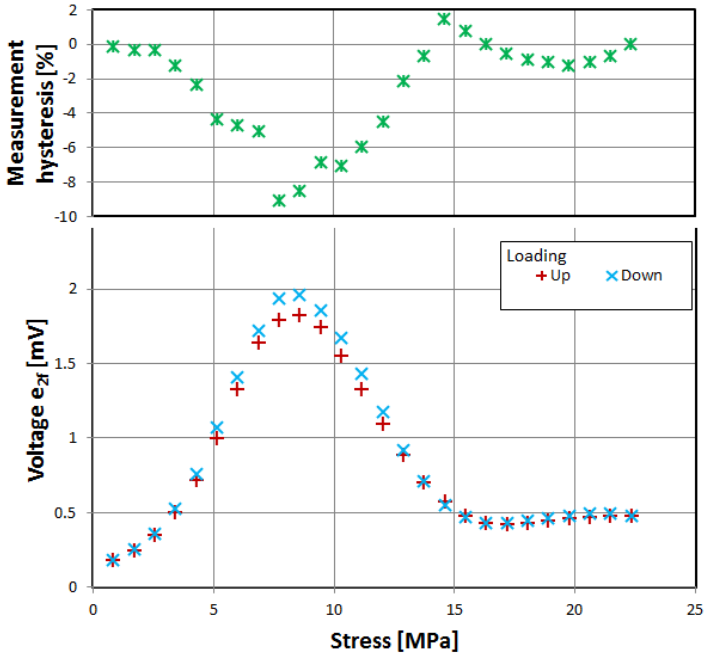
Figure 3. Dependence of induced e 2f voltage on tensile stress, alloy 2714A.